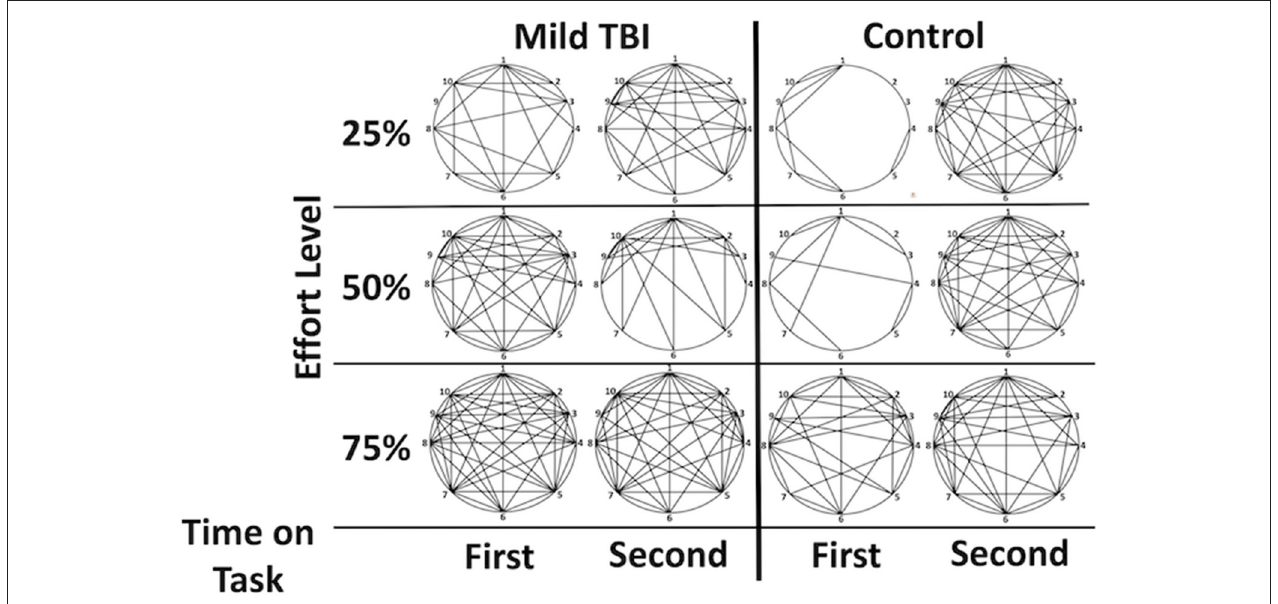
FIGURE 3 | Graphical demonstration of functional connectivity between the Effort regions by group and phase highlights the (1) increased connectivity in the mTBI group and the relative difference between phases one and two in the control group that is not as evident in the mTBI. Lines indicate a functional connection between two regions at z > 3. Correlations between functional connectivity strength and time post injury were minimal but existed between the 2 right insular regions for the second half of the 25% effort level trials ( r = − 0.372), between the left and right insula for the first half of the trials at 75% ( − 0.302 for right insula; − 0.374 for right insula F03). Legend: 1 = dorsal ACC, 2 = rostral ACC, 3 = right inferior frontal operculum, 4 = right insula (orbitofrontal), 5 = right insula, 6 = left postcentral gyrus, 7 = left insula, 8 = left precentral gyrus, 9 = right inferior frontal gyrus (p. orbitalis), 10 = superior medial frontal gyrus.